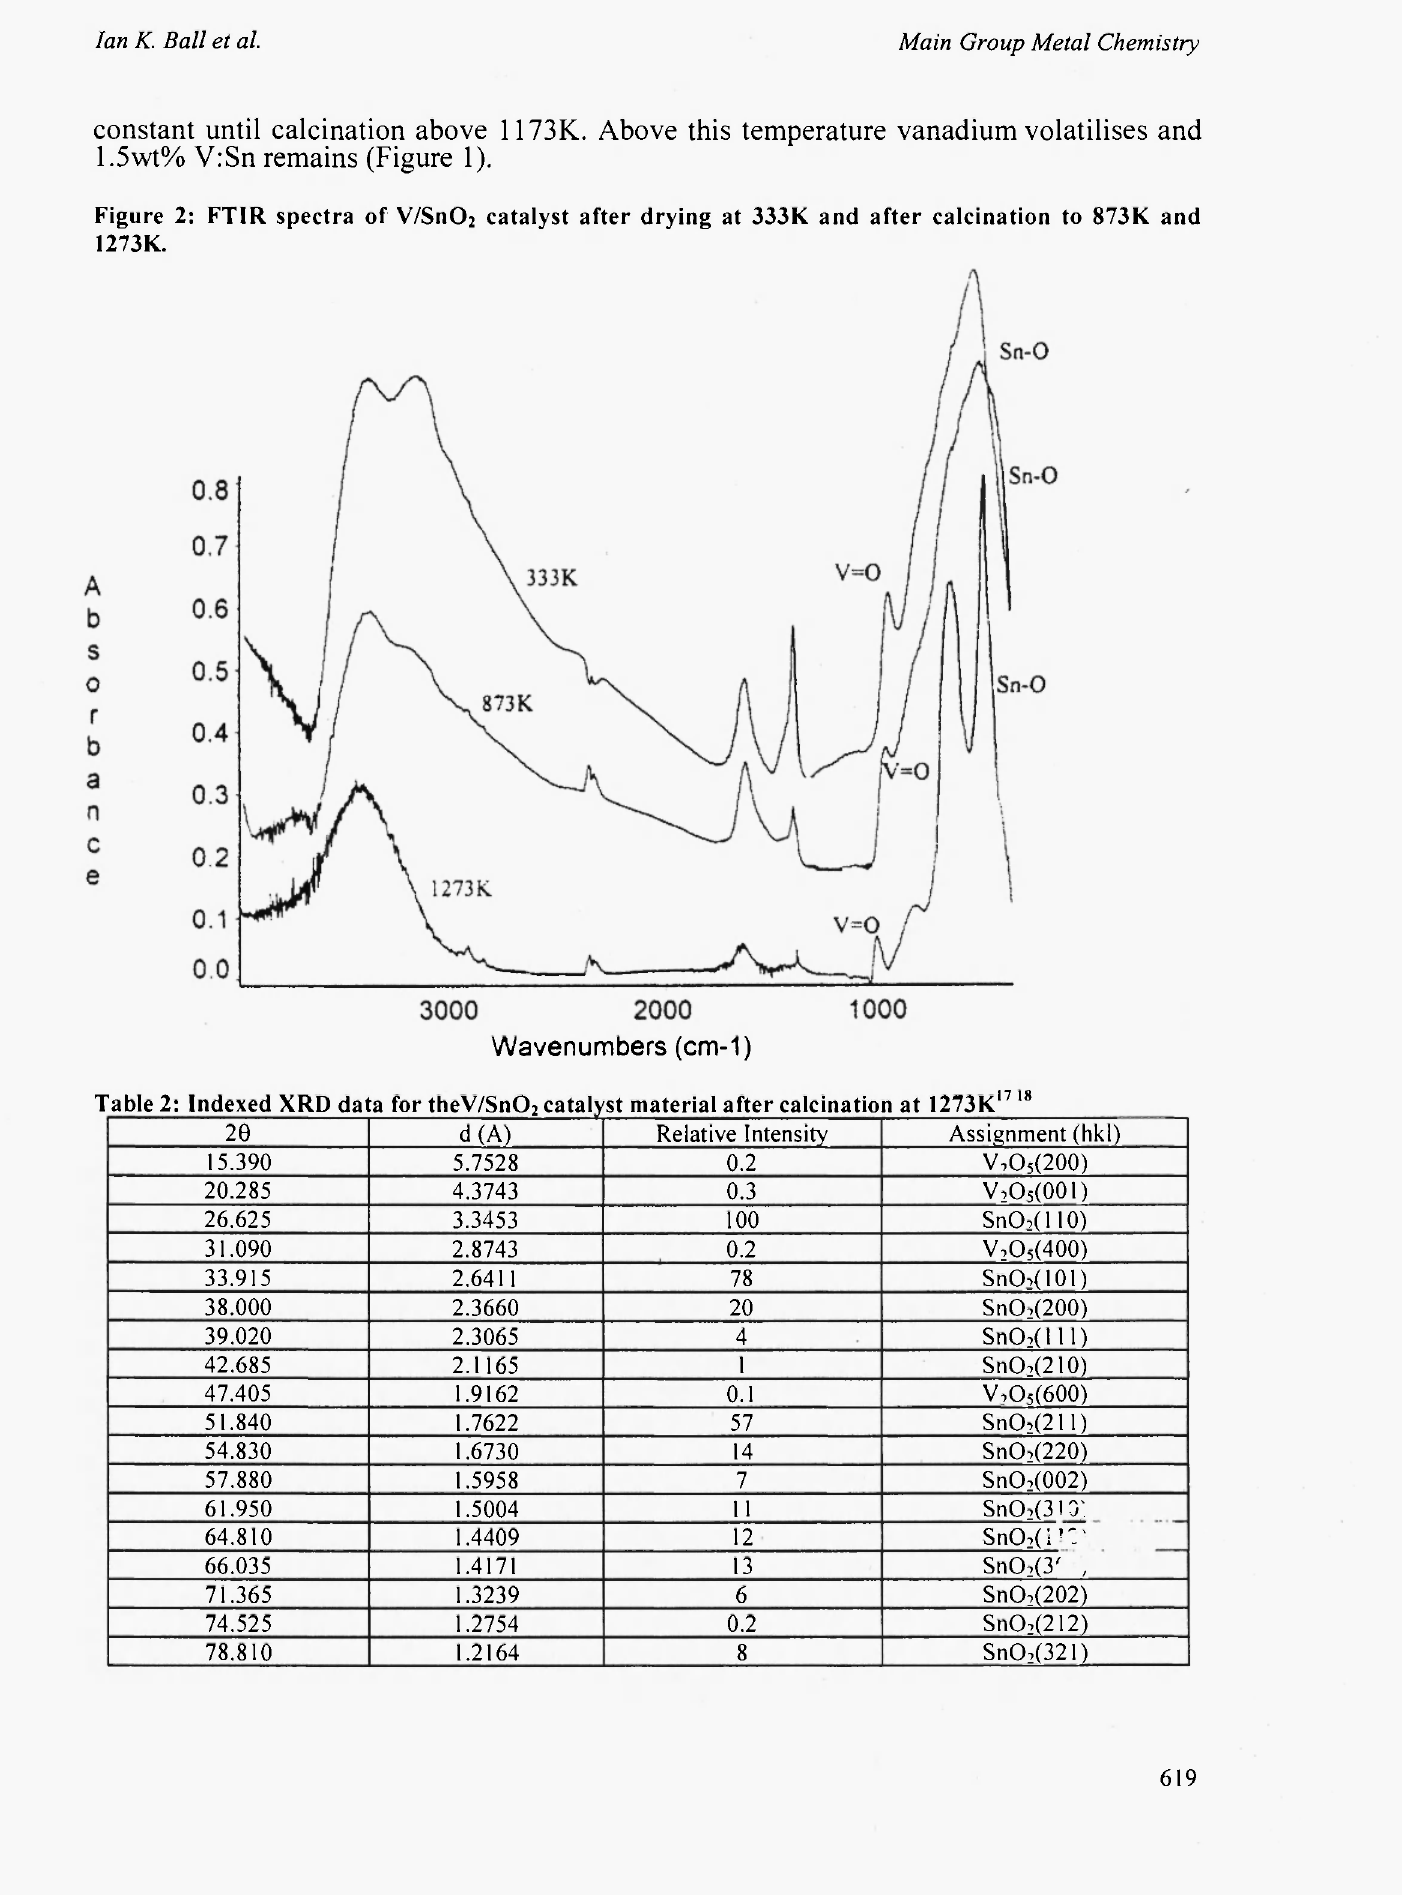
Figure 2: FTIR spectra of V/Sn0 2 catalyst after drying at 333K and after calcination to 873K and 1273K.